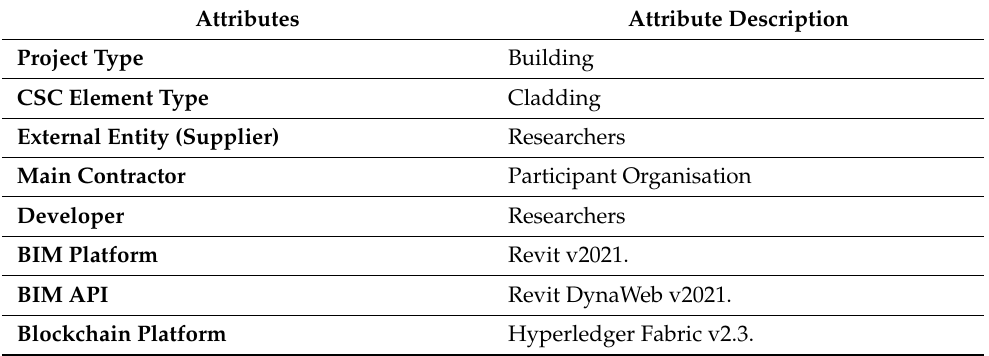
Table 1. Protocol for the virtual business scenario.